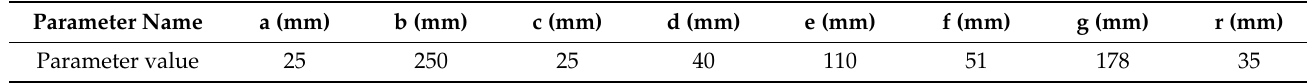
Table 2. Design parameters of the lightweight drive rod.